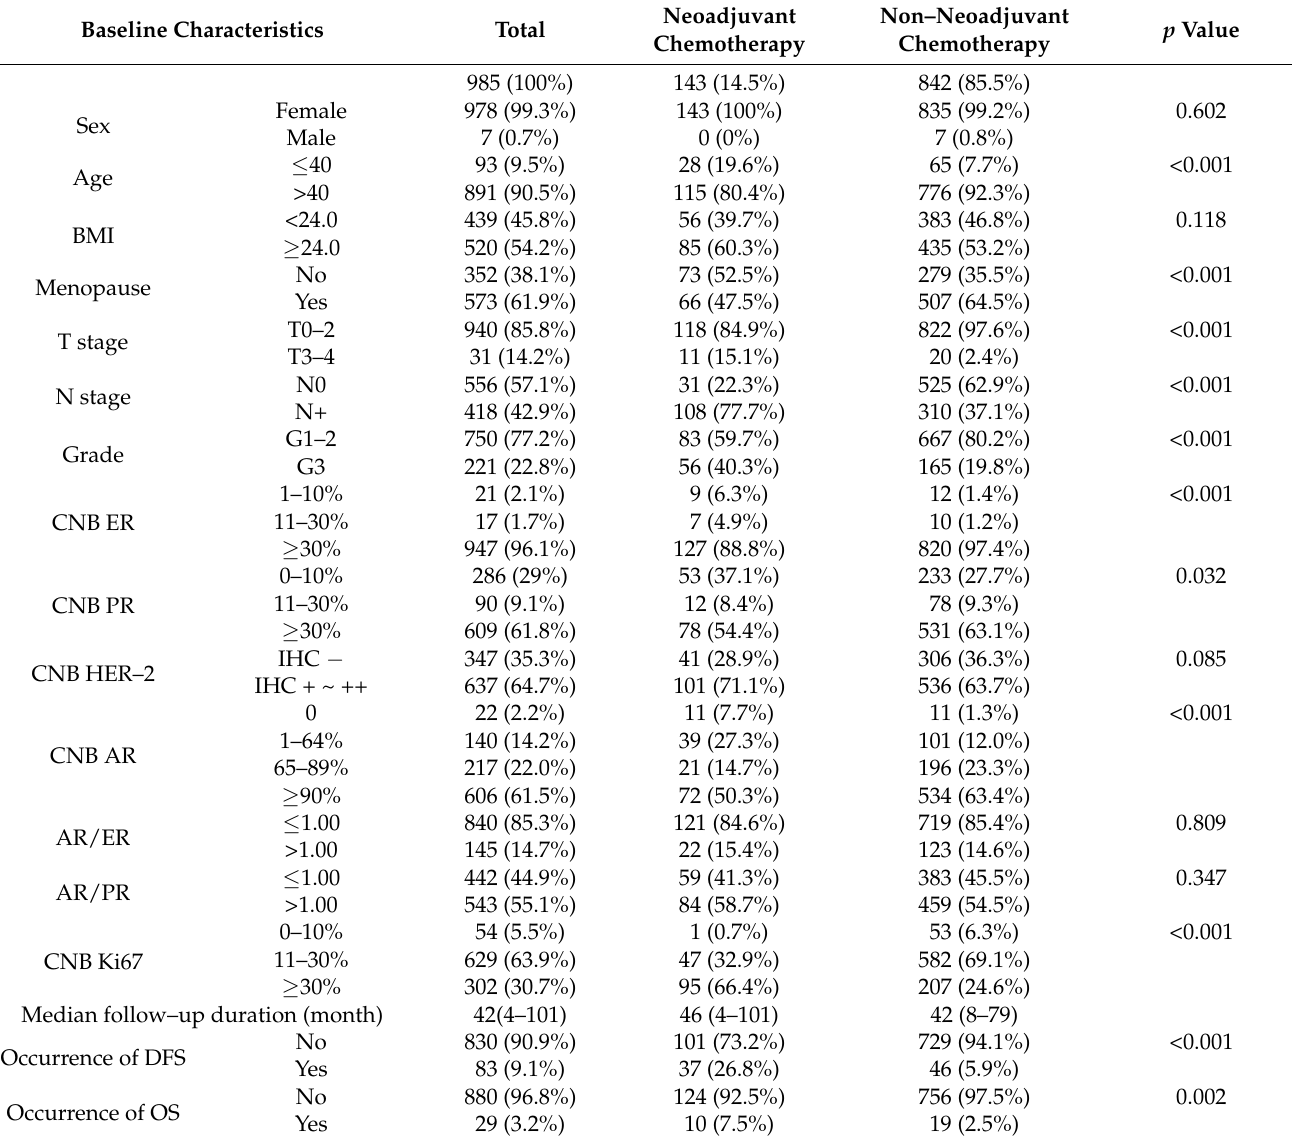
Table 1. Baseline characteristics of the luminal B (HER–2 negative) BC study